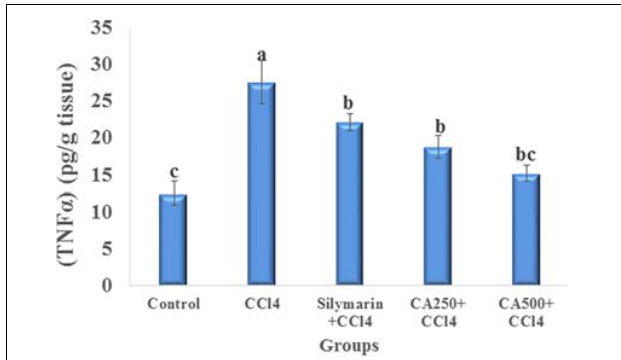
FIGURE 3 | Anti-inflammatory effect of reference drug silymarin, CA250 and CA500 against CCl 4 induced hepatotoxicity on tumor necrosis factor alpha (TNF α ). Data are the mean ± standard deviation ( n = 8); a , b, or c significantly different at p < 0.05 using ANOVA followed by Tukey as a post hoc test.